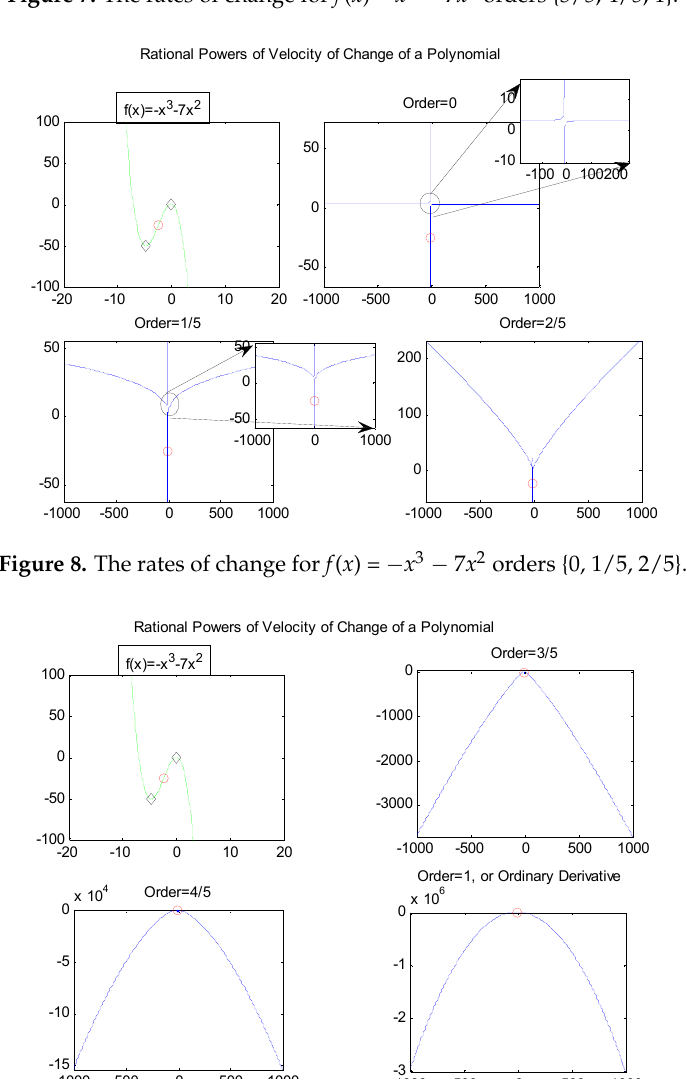
Figure 9. The rates of change for f ( x ) = x 3 − 7 x 2 orders {3/5, 4/5, 1}.